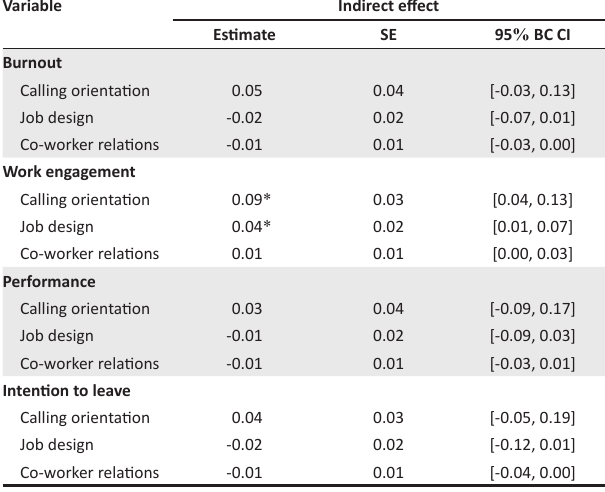
TABLE 5: Indirect effects on burnout, work engagement, performance and intention to